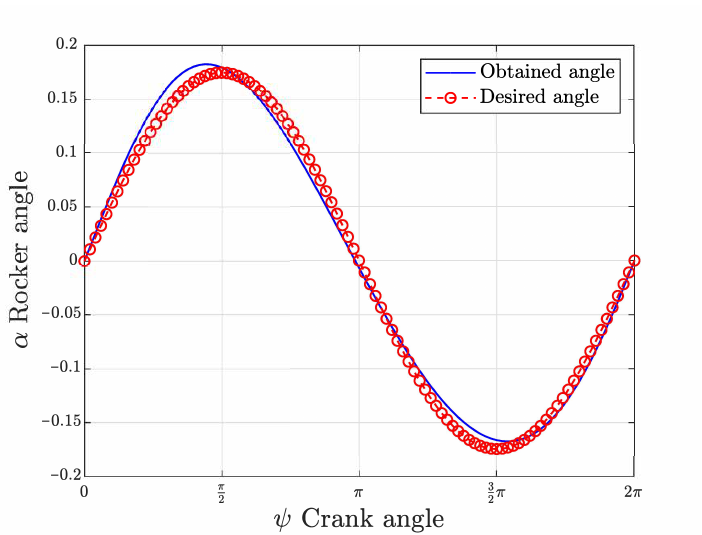
Figure 7. A comparison between the desired angle α and the one obtained with the four-bar linkage.